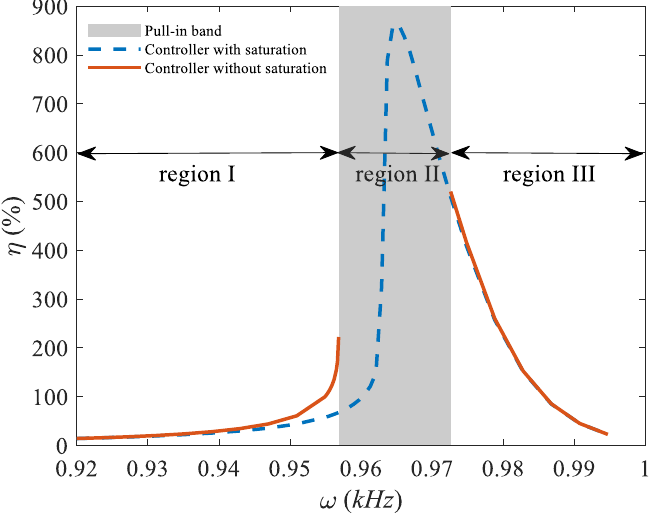
Figure 4. The efficiency of the controller with and without saturation .